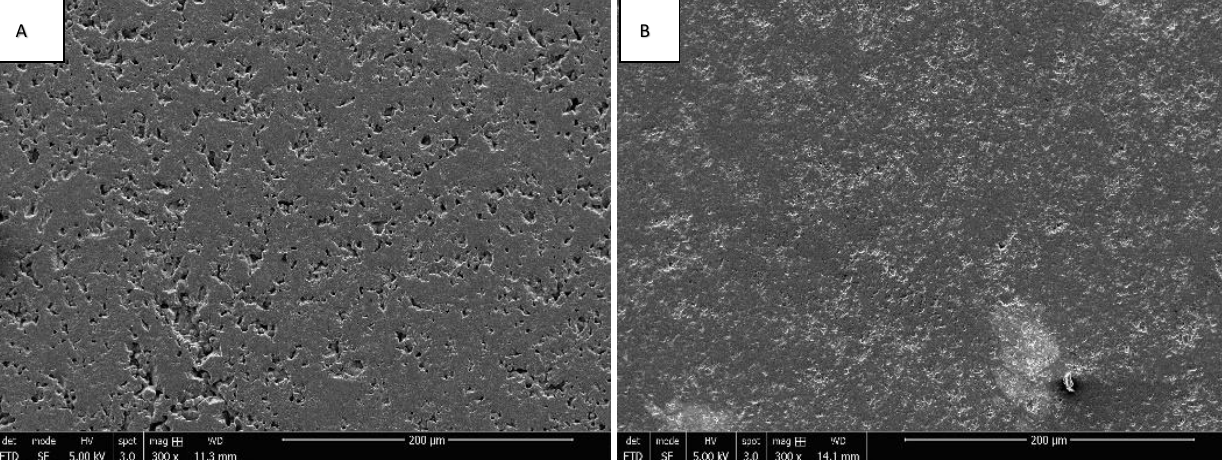
Figure 3 . SEM images of smooth surfaces of ZrO 2 (( A ) magnification 300×) and Y-TZP (( B ) magnification 300×) discs.